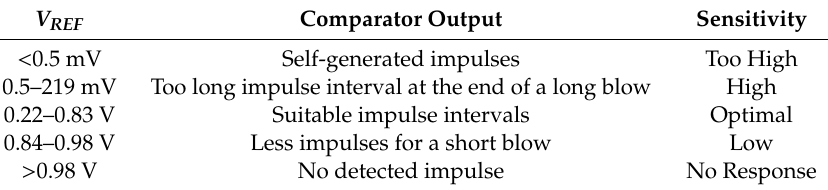
Table 2. Detection sensitivity dependence on the reference voltage value .